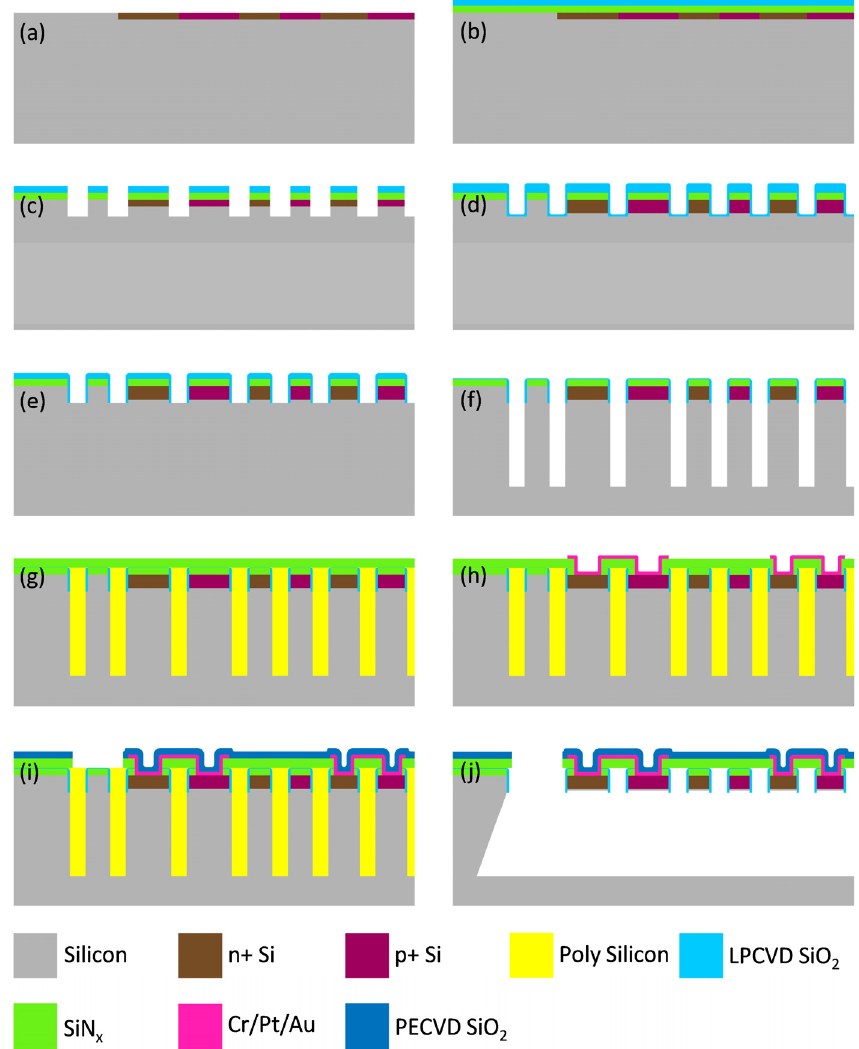
Figure 2. The fabrication process of the MEMS thermopile sensors for DTA. ( a ) N-type and p-type ion implantation. ( b ) Dielectric film deposition. ( c ) Thermocouple patterning and thickness definition. ( d ) Sidewall protection layer deposition and diffusion. ( e ) Sidewall protection definition. ( f ) DRIE etching. ( g ) Trench-filling with polysilicon, self-stopping polishing, and supporting film deposition. ( h ) Contact hole patterning, metal sputtering, and electrode patterning. ( i ) SiO 2 deposition and release hole patterning. ( j ) TMAH wet etching.